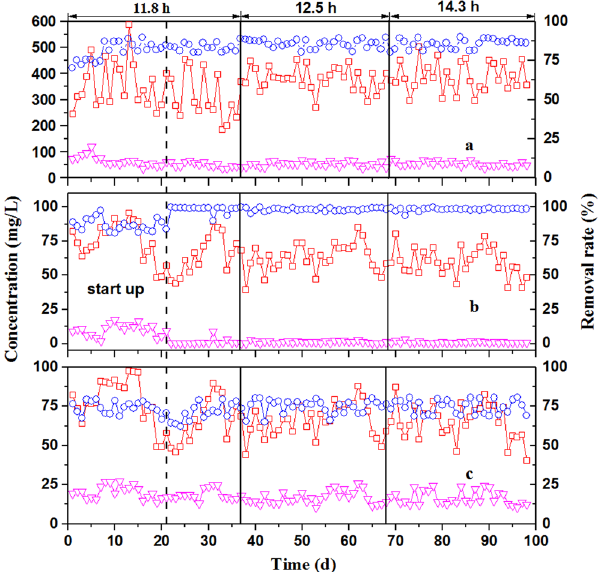
Figure 1. Treatment performance of the A/O-MBR: ( a ) COD; ( b ) NH 3 -N; and ( c ) TN. &#x25A1; : Influent concentration, ∇ : effluent concent ration, and &#x26AA; : removal rate.